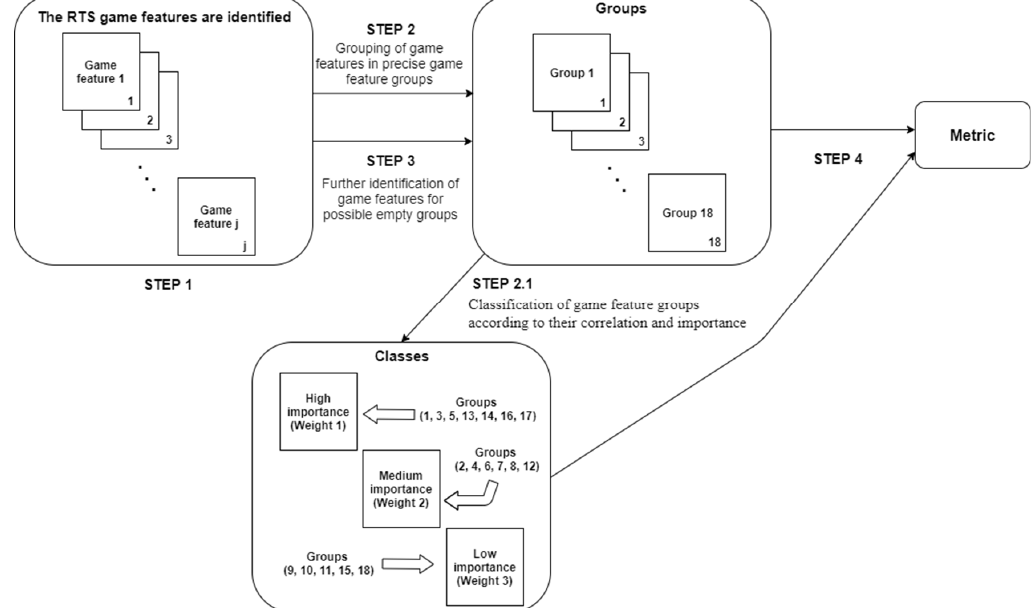
Figure 2. Pathway (steps taken) from the identification of the RTS game features to the novel metric.